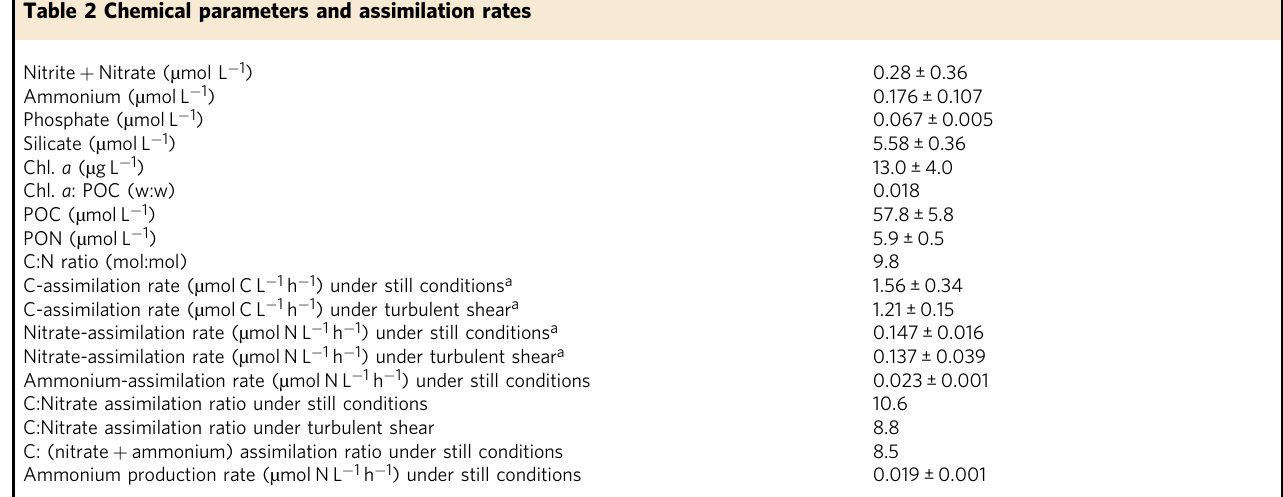
Nutrient concentrations, Chl. a , POC, and PON in ambient water. C-, nitrate and ammonium assimilation rates, and ammonium production rates of the phytoplankton community. The numbers are average values±standard deviation of the mean value ( n = 3) POC: particulate organic carbon, PON: particulate organic nitrogen a Values of community C- and nitrate-assimilation rates were statistically similar under still conditions and under turbulent shear (ANOVA two-way, p >0.05)